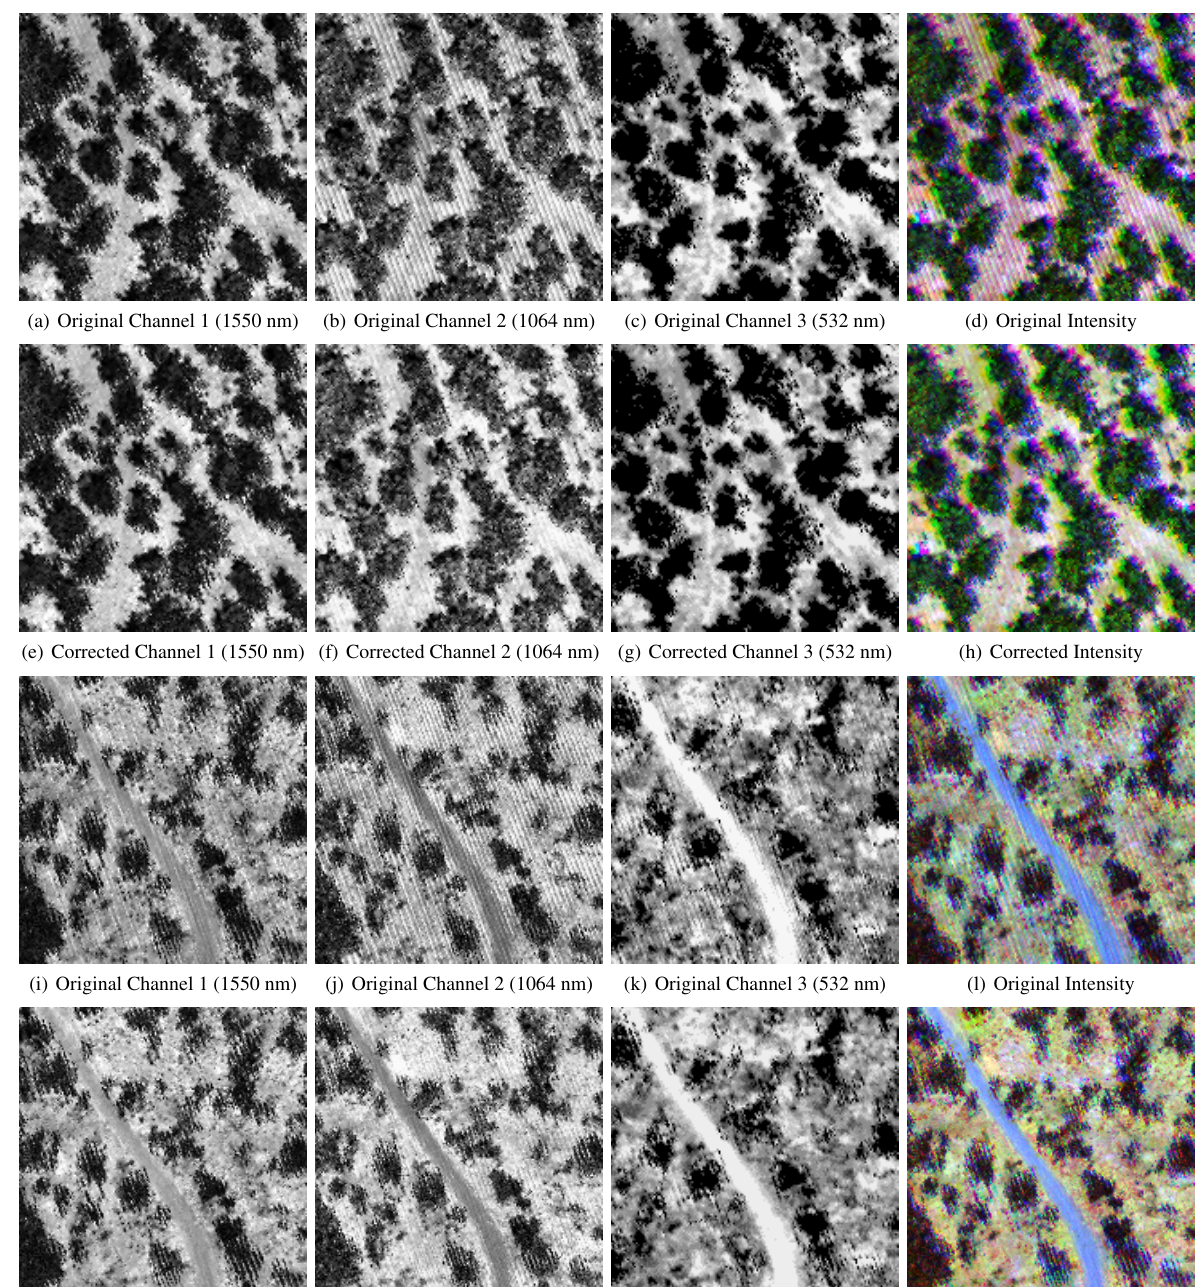
Figure 3. Multispectral LiDAR intensity image before and after radiometric